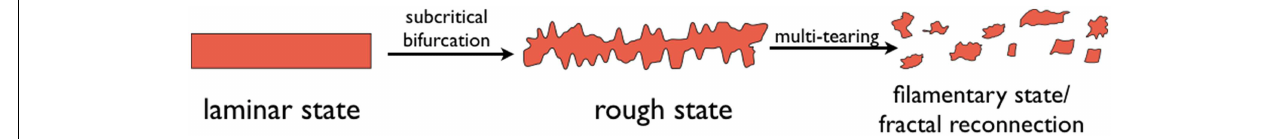
FIGURE 4 | Sketch of the formation of rough CS and the following